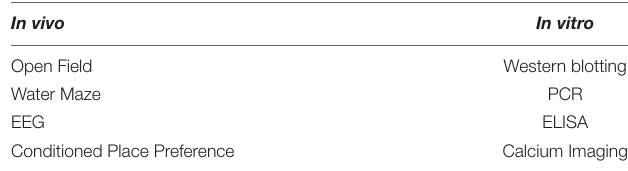
TABLE 1 | The four initial in vivo and in vitro neuroscience protocols selected for the PEERS